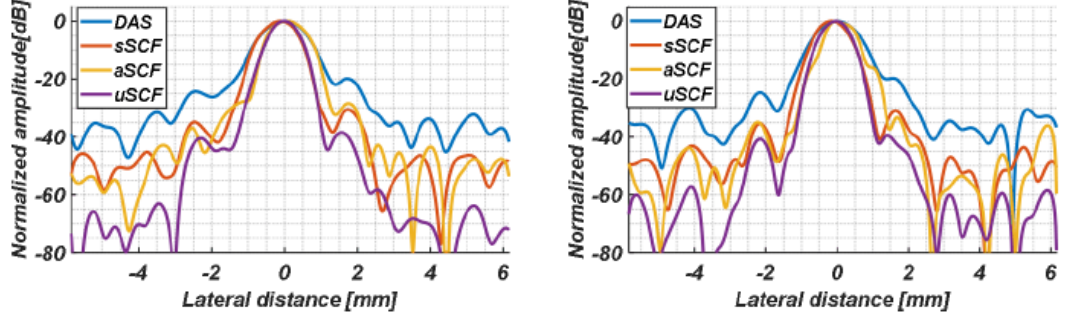
Figure 4. The lateral variations of the selected points in the simulated images at various depth. Left, 10 mm; right, 15 mm.